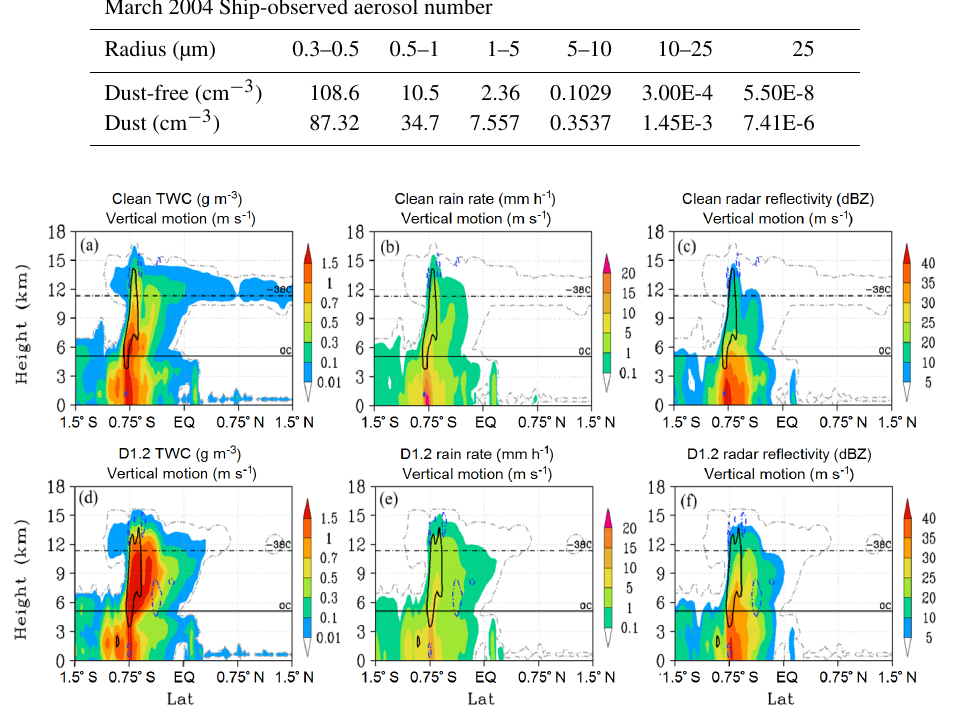
Figure 2. Zonally averaged longitude slice plot of similar DCC structures within the Clean (row 1) and D1.2 (row 2) cases. Shaded colors: total water content (TWC; column 1), vertical rain rate (column 2), and radar reflectivity (column 3); line contours, all columns: vertical motion (solid black >1ms − 1 ; dashed blue < − 0 . 1ms − 1 ), cloudiness threshold (dashed grey, >1 × 10 − 6 kgkg − 1